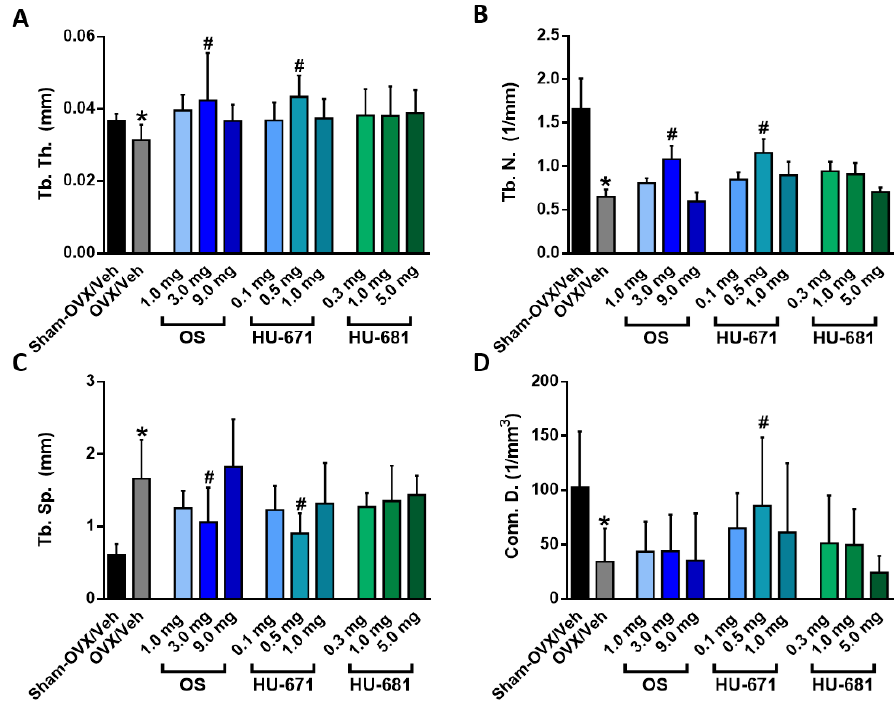
Figure 3. Microstructural analysis of trabecular bone parameters in the distal femoral metaphysis of OVXed mice treated with OS and its methylated derivatives. Trabecular thickness (Tb. Th.) ( A ).